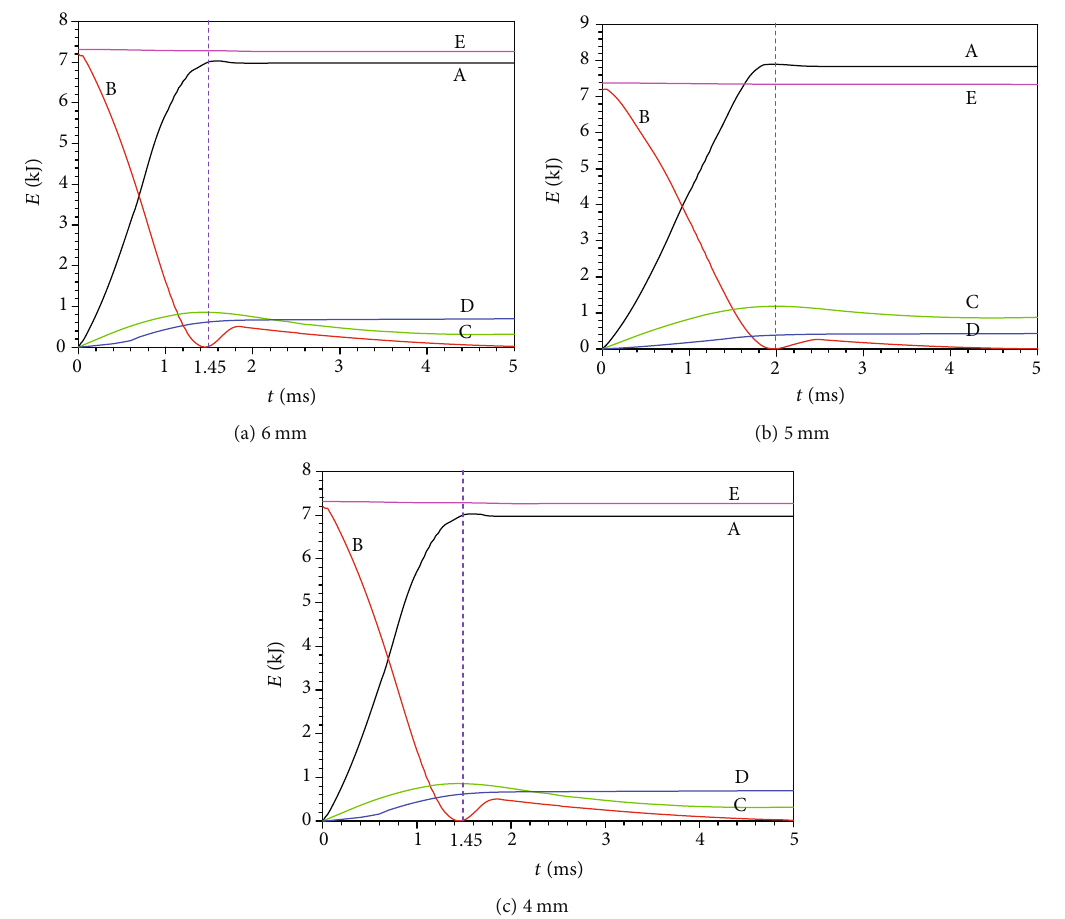
Figure 3: Energy absorption process for metal tubes of di ff erent outer diameters. A: internal energy of the metal tube; B: kinetic energy of the ascending object; C: work done by external load; D: frictional energy consumption; E: total energy of the